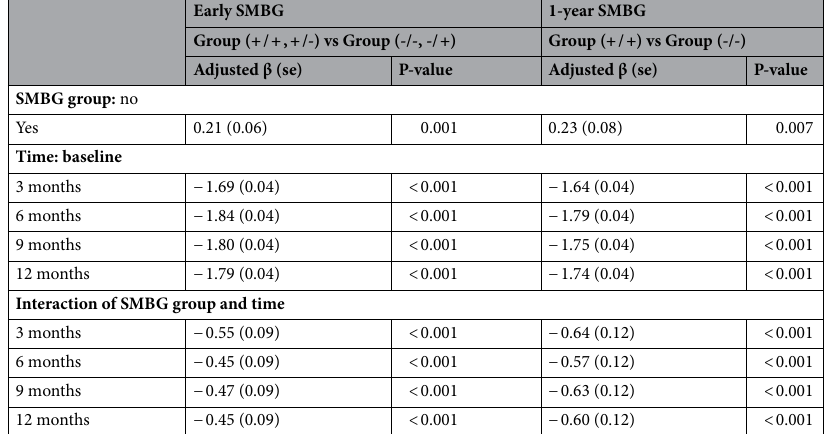
Table 3. Longitudinal HbA1c trajectory by generalized estimating equations. The models were adjusted for age at onset, gender, level of education, smoking status, physical activity, medication adherence, HbA1c at baseline, body mass index, systolic blood pressure, triglycerides, high-density lipoprotein cholesterol, low- density lipoprotein cholesterol, using insulin secretagogues, and Charson comorbidity index. Results are expressed as regression coefficients (β) with their corresponding standard error (se). Backward elimination method was adopted to select variables. Abbreviations: SMBG, self-monitoring of blood glucose; HbA1c, hemoglobin